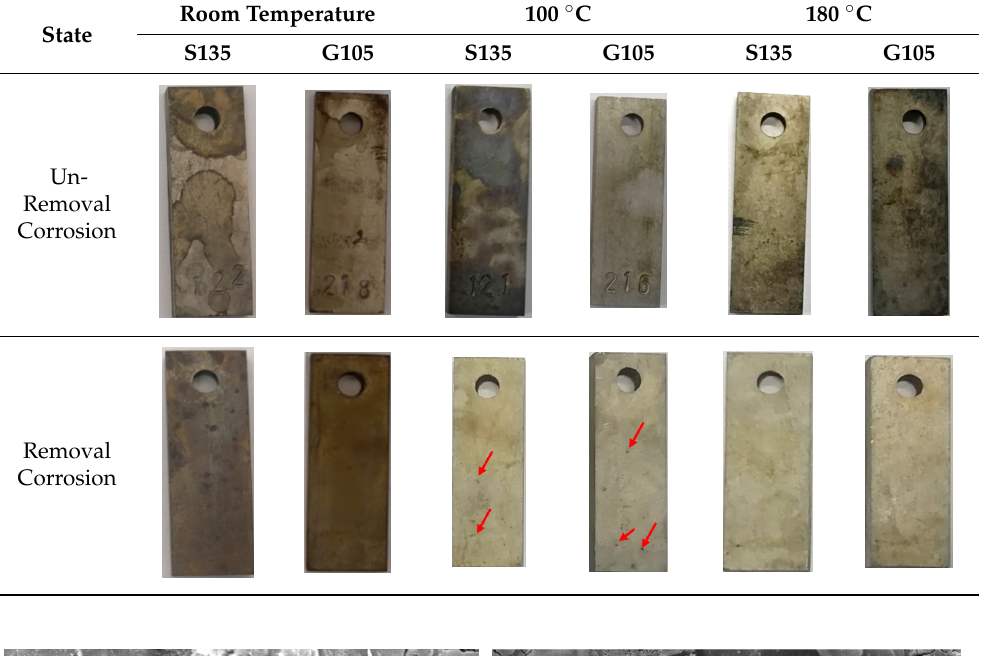
Table 3. Optical photographs of S135 and G105 materials after corrosion at room temperature, 100 °C and 180 °C, respectively.